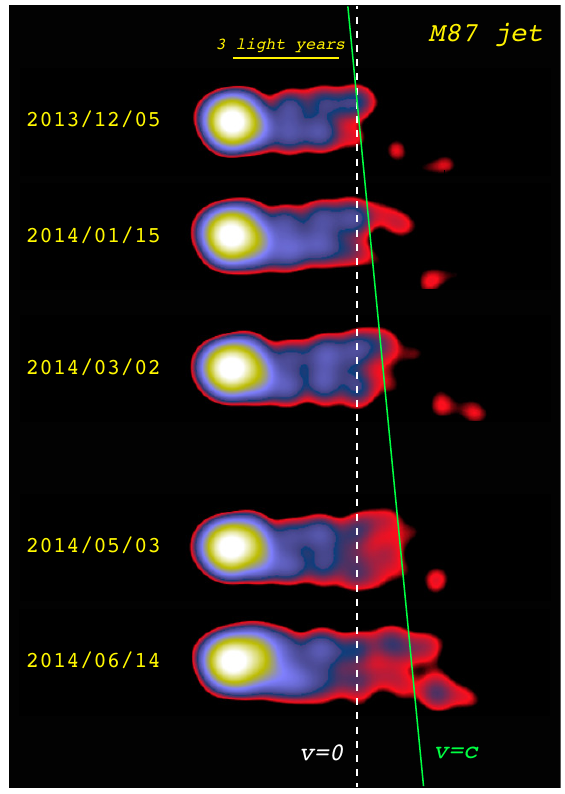
Figure 4. Multi-epoch KaVA 22GHz images of the M87 jet. All the images are convolved with a 1mas circular beam. The green straight line corresponds to a constant velocity at the speed of